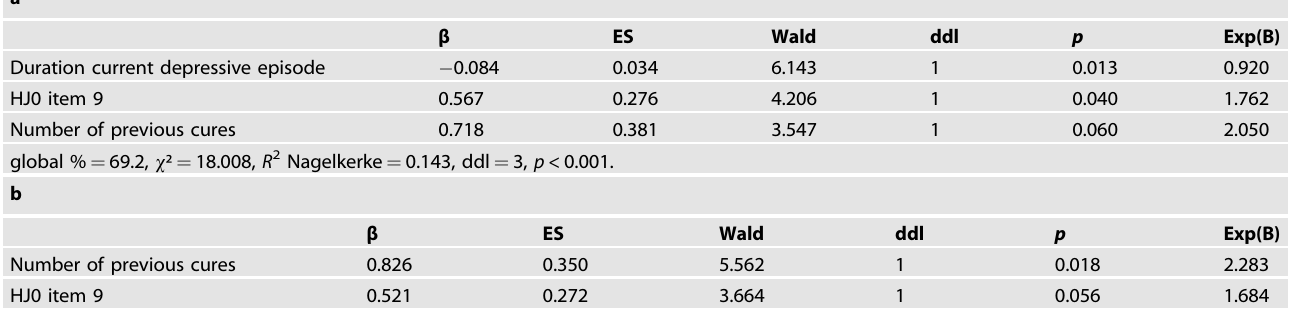
Table 3. Predictive factors (stepwise binary logistic regression) at M1 under gold standard (a) and quartiles (b) analysis.